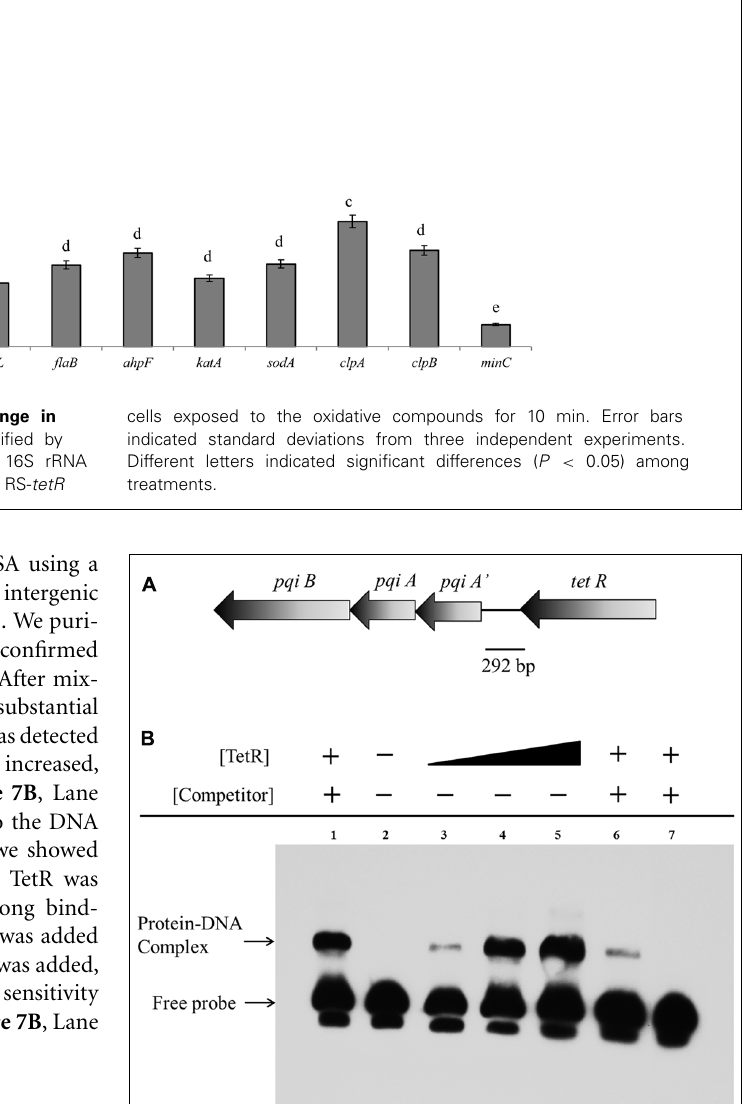
FIGURE 7 | Electrophoretic mobility shift assay ofTetR binding to the pqiA’-tetR intergenic region. (A) The 292 bp DNA fragment comprising the intergenic region between the tetR and pqiA’ genes was amplified by PCR and used as probe in EMSAs. (B) Detection of protein–DNA complexes by EMSA using 0.05 pmol labeled probe incubated with increasing amount of GST-TetR protein (0 mg, Lane 2; 0.20 mg, Lane 3; 0.40 mg Lane 4; 0.60 mg, Lane 5).The 5 pmol unlabelled non-specific DNA, 0.05 and 5 pmol unlabeled specific DNA (cold competitor probe) was mixed and incubated with 0.40 mg purified GST-TetR protein before adding labeled specific probe in Lane 1, Lane 6 and Lane 7, respectively.